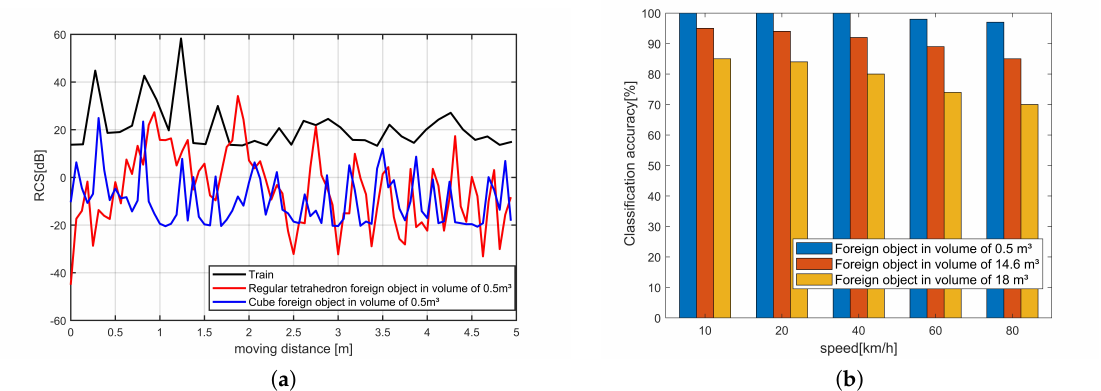
Figure 15. Simulation results of classification accuracy. ( a ) RCS of train and foreign objects. ( b ) Impact of train’s speed and foreign object’s volume on classification